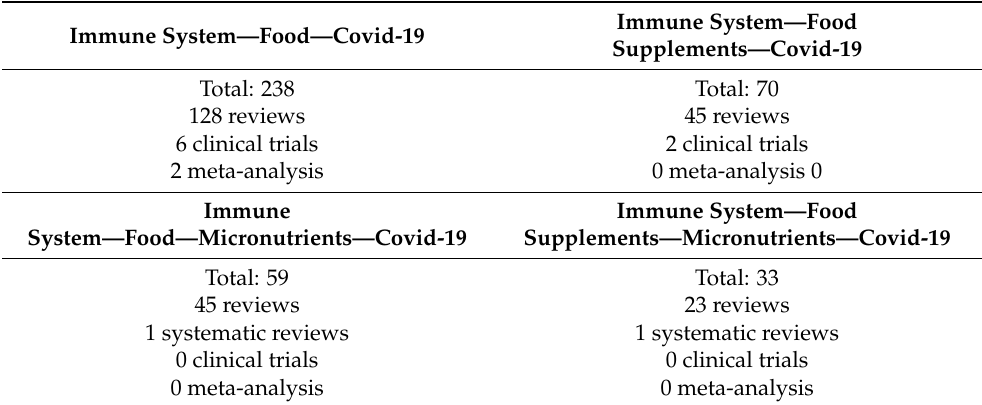
Table 3. Summary of the studies found in PubMed by using ‘immune system’, ‘COVID-19 (cid:48) , ‘food’, or ‘food supplements’ as